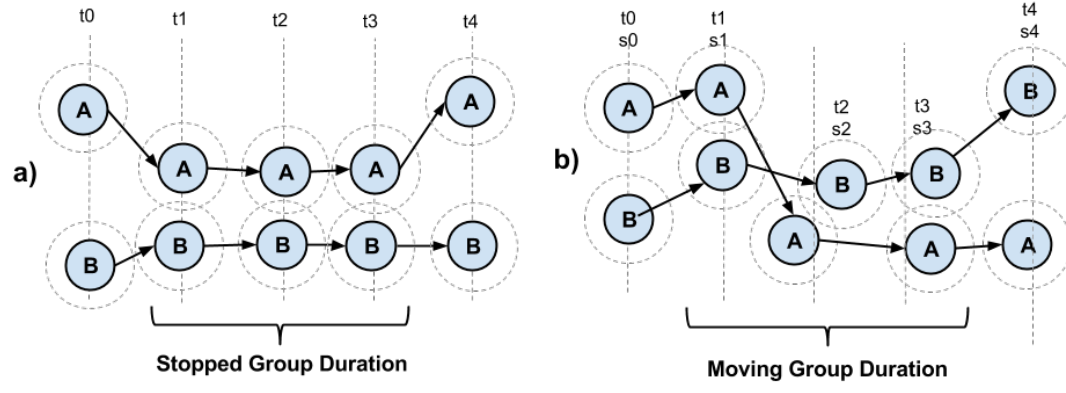
Figure 3. ( a ) Anklet monitoring system with stopped group detection; ( b ) Anklet monitoring system with moving group detection. Source: the